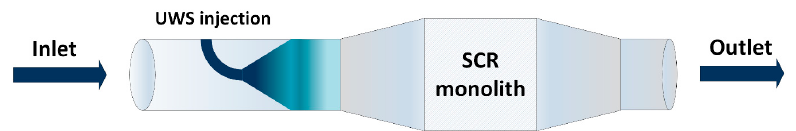
Figure 1. Typical urea-based selective catalytic reduction (SCR) system in the exhaust pipe.